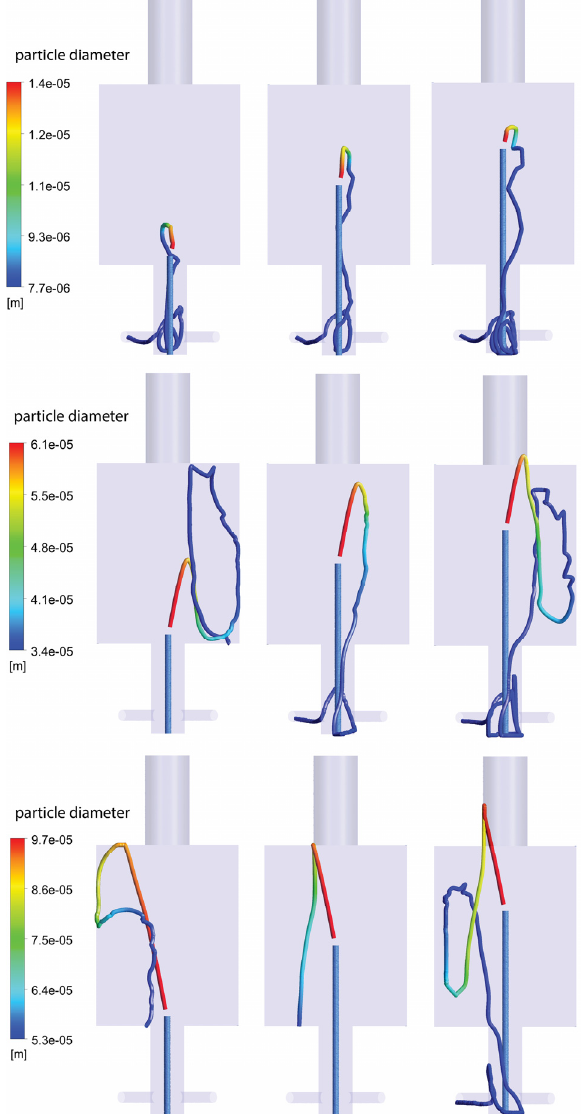
Figure 8. Particle trajectories of 1.4 × 10 − 5 m (top), 6.1 × 10 − 5 m (middle), and 9.7 × 10 − 5 m (bottom), for three different nozzle positions: 3 cm (left); 23 cm (middle); and 33 cm (right).